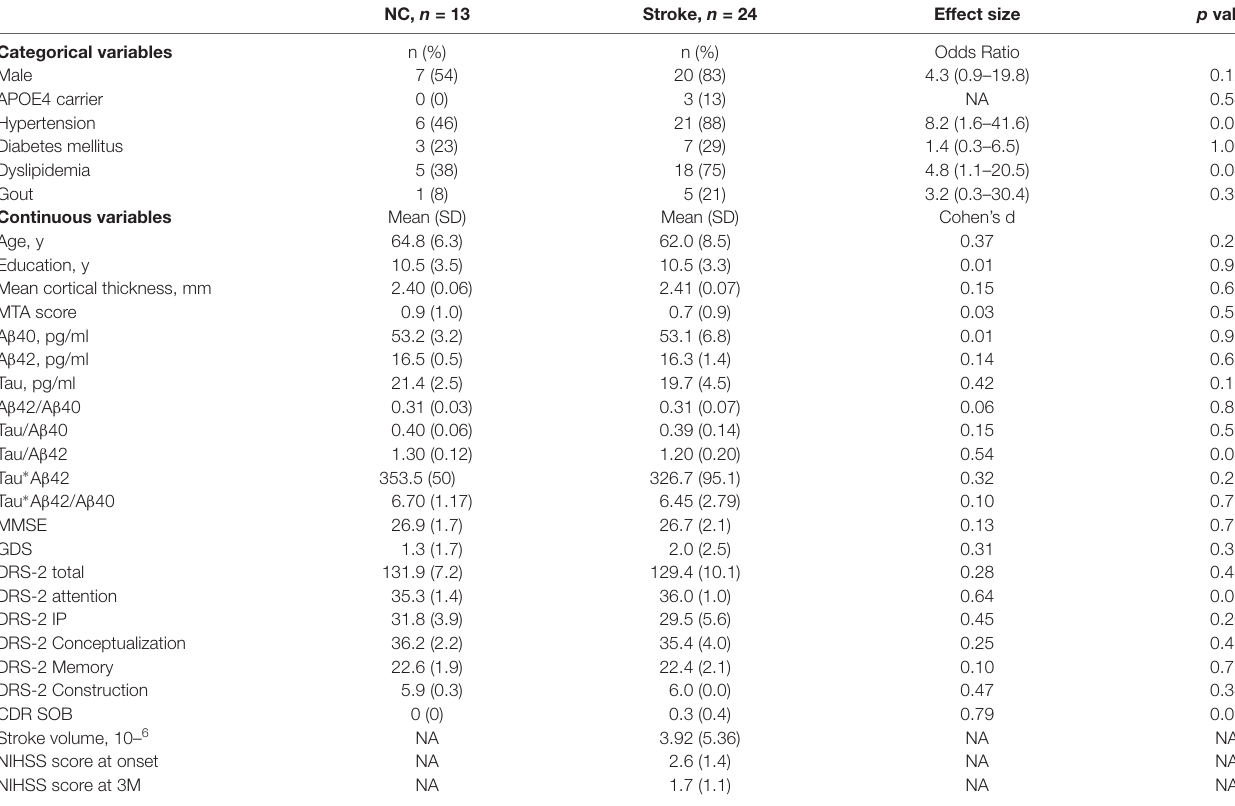
TABLE 1 | Comparisons of demographic data and plasma A β 40, A β 42, tau protein and their composite scores between normal controls and patients with ischemic stroke. NC, n = 13 Stroke, n = 24 p value